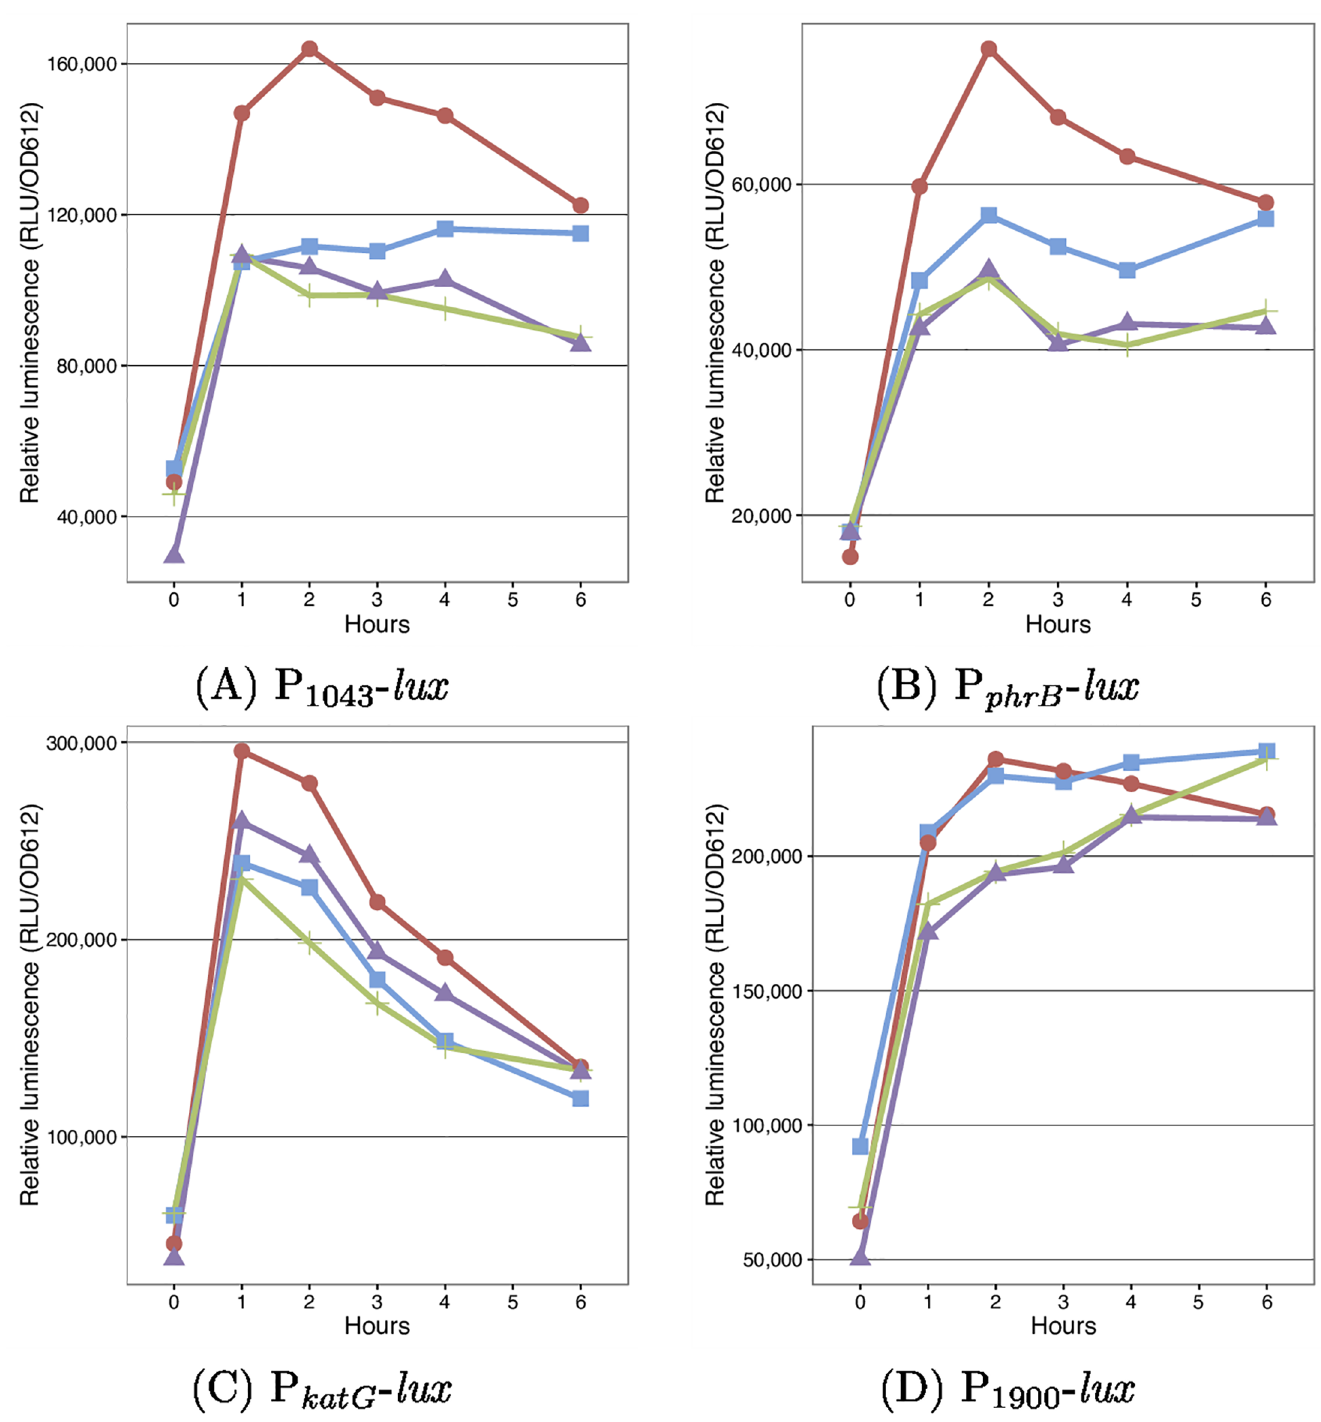
Fig 5. Expression from candidate PSPTO_1043 promoters in the presenceof tBOOH. WT (blue and red) or Δ PSPTO_1043/1042 (green and purple) strains carrying promoter- lux fusions were grown in the presence(red and purple) or absence(blue and green) of 0.1mM tBOOH.